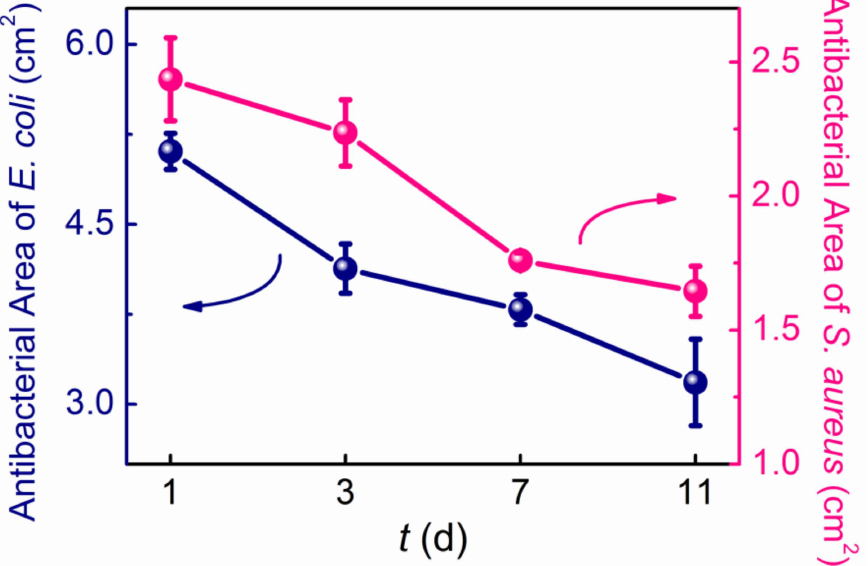
Figure 3. The detailed antibacterial area of the inhibition zone test for the as-made Ni-PW against E. coli and S. aureus